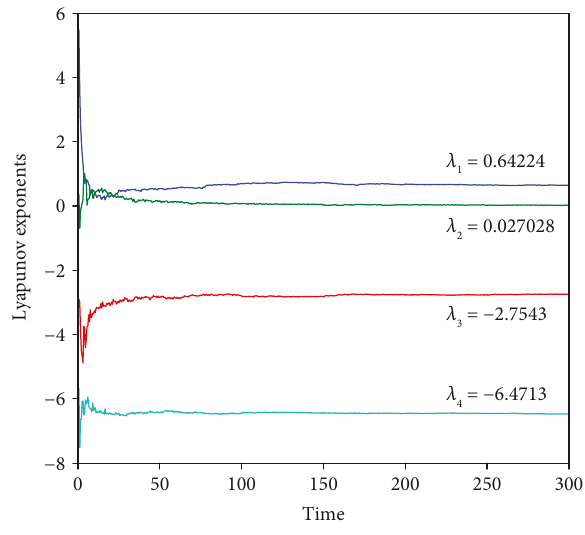
Figure 8: Lyapunov exponents